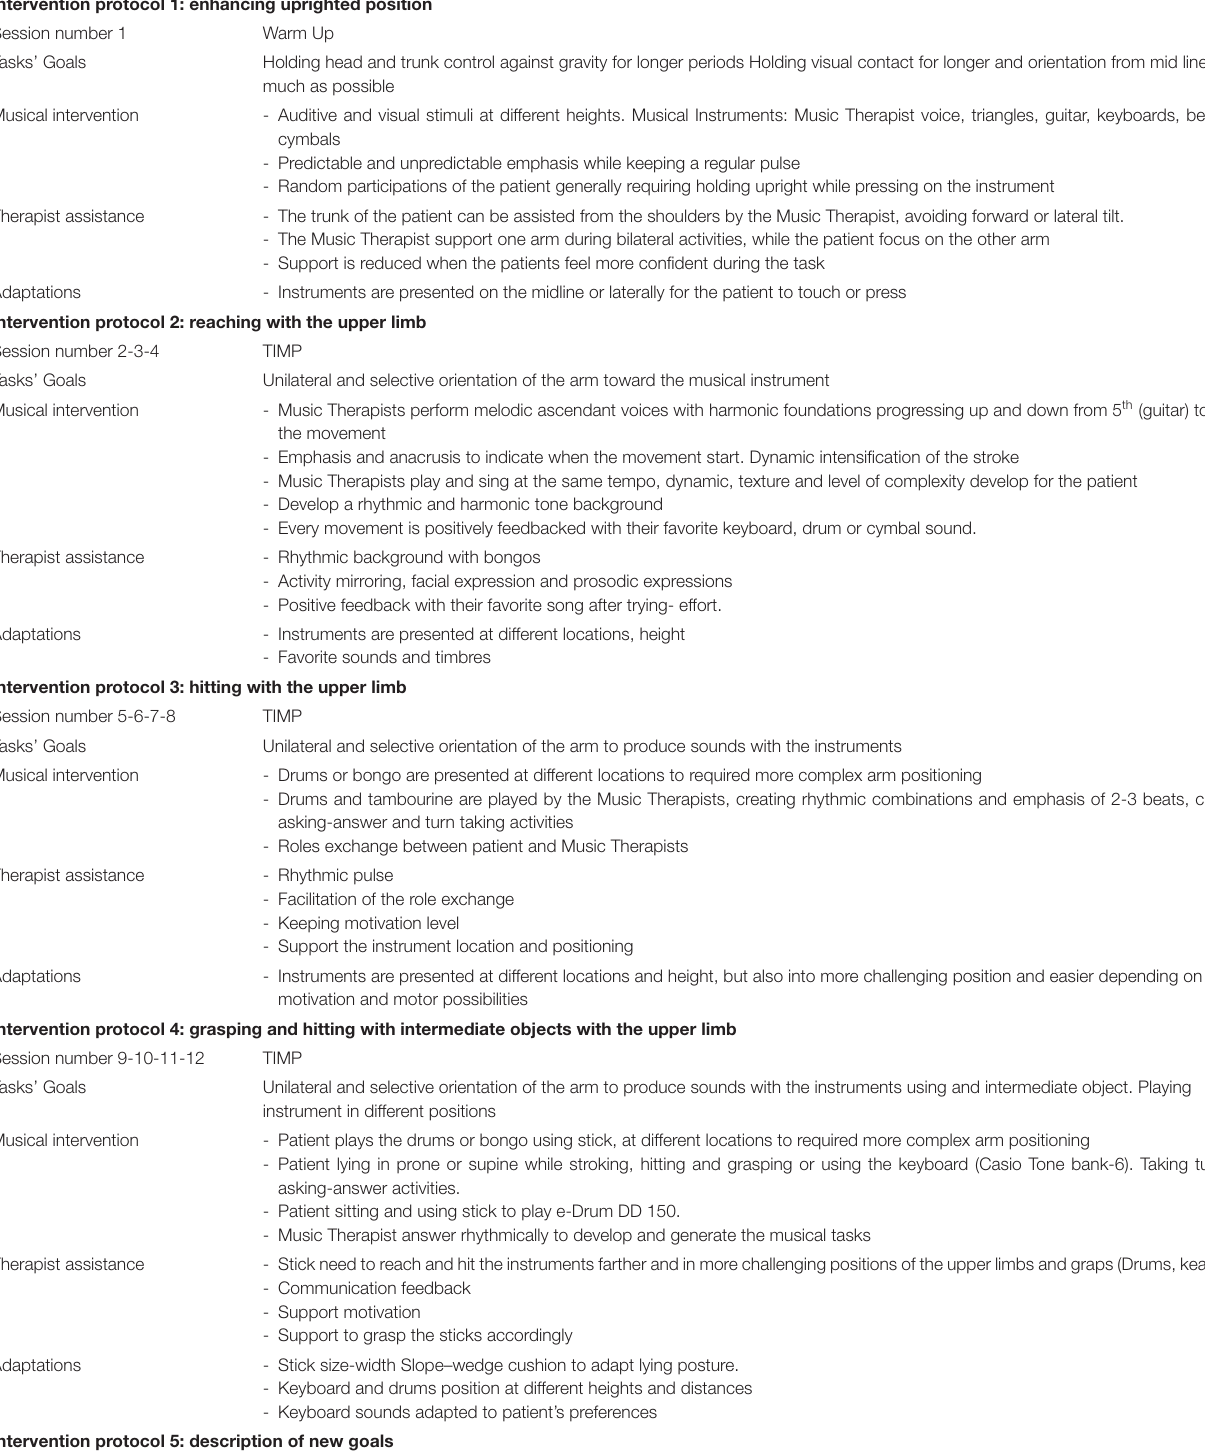
Intervention protocol 5: description of new goals Session number